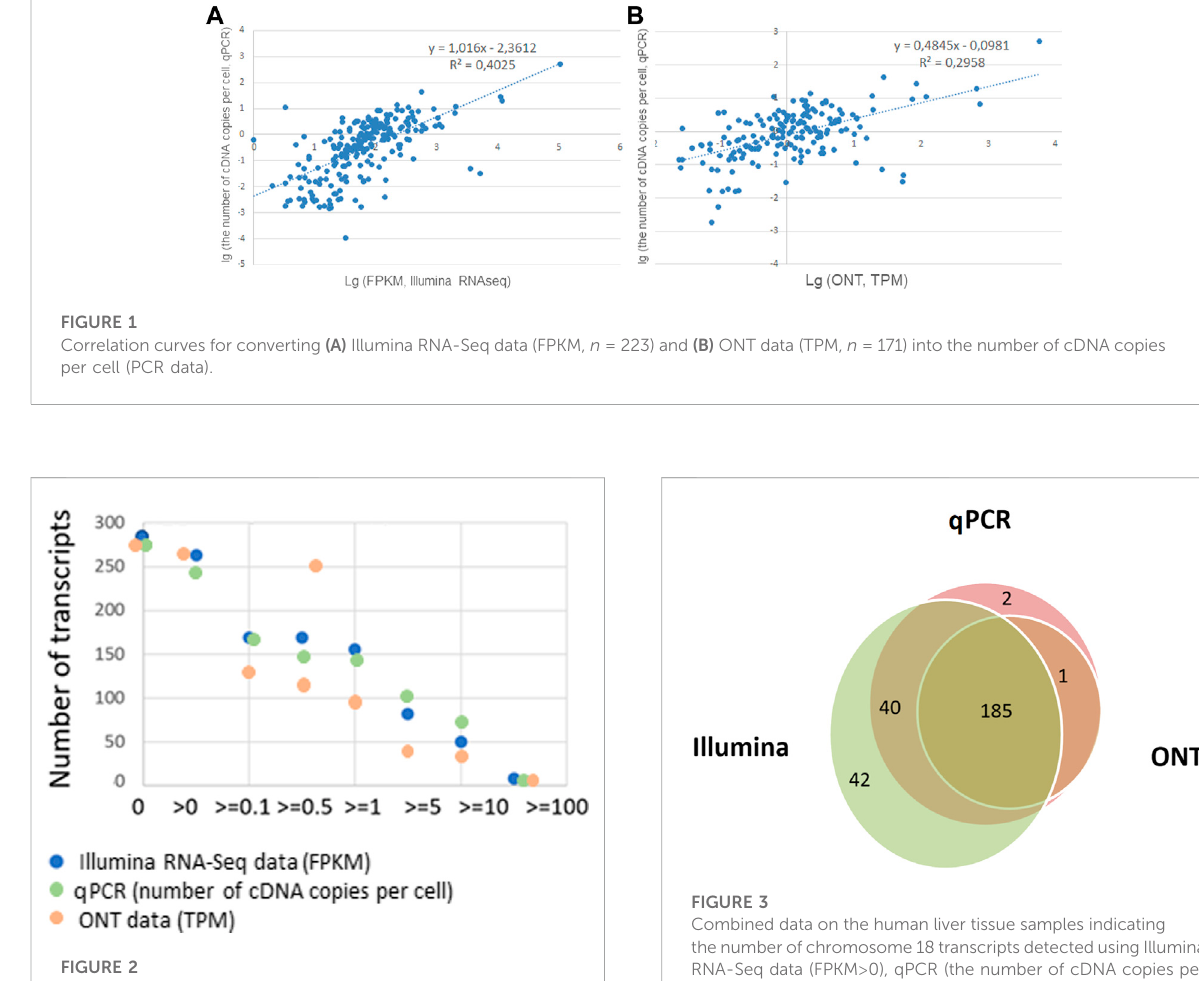
FIGURE 2 Dependence of the number of detected liver tissue sample transcripts encoded by chromosome 18 ( n = 275) for various platforms: Illumina RNA-Seq data (FPKM), qPCR (number of cDNA copies per cell, S t ≤ 40), and ONT data (TPM) on the cut-off level and the concordance of the results obtained with the known genome of chromosome 18.